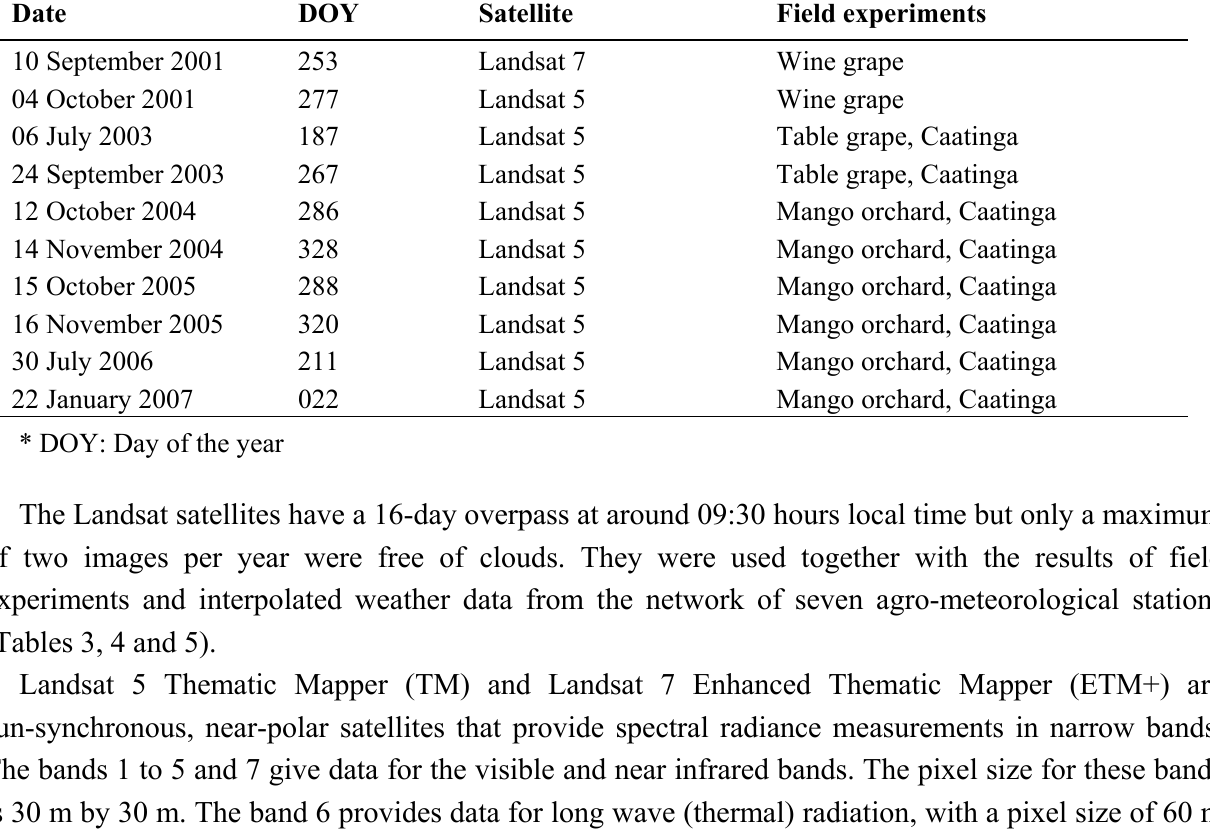
DOY Satellite Field